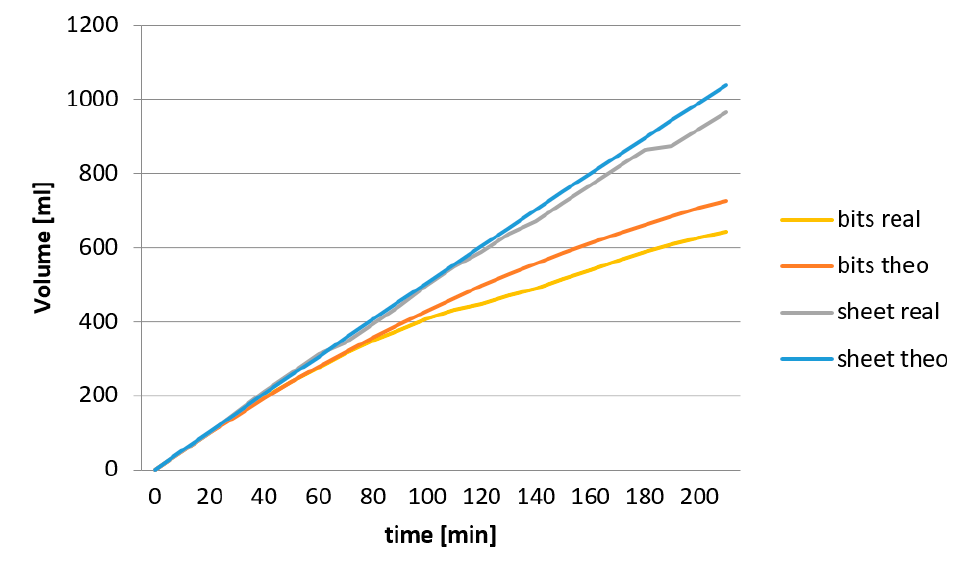
Figure 4. Comparison of the hydrogen volume generated from 104 sheet metal chips of 2 × 2 × 0.5 mm 3 (bits) and a plate of 20 × 30 × 0.5 mm 3 (sheet) of aluminum A1, of the same initial active surface 1240 mm 2 in a 7.5 M NaOH (non-alcohol) solution at a bath temperature of 25 °C.